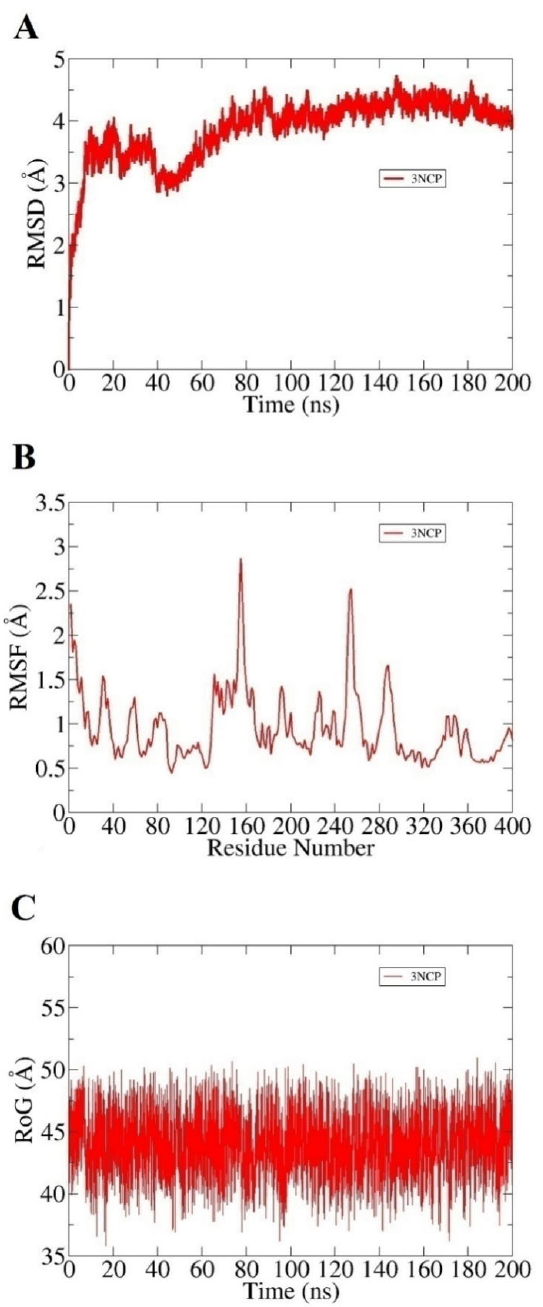
Figure 2. System stability evaluation based on the MD simulation trajectories. ( A ) RMSD, ( B ) RMSF, and ( C ) RoG.